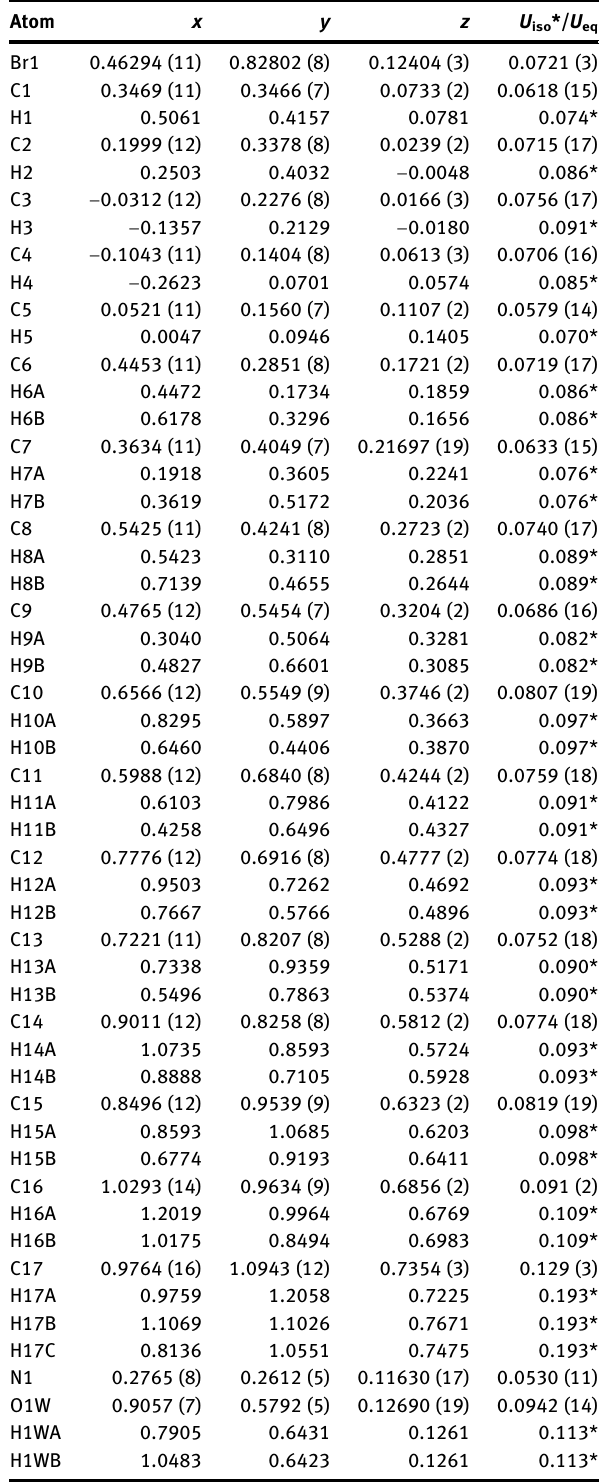
Table  : Fractional atomic coordinates and isotropic or equivalent isotropic displacement parameters (Å 